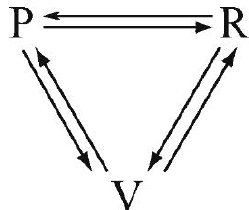
Figure 1: The Original Drama Triangle However, over time with popular usage and with the ease of drawing it on a blackboard, others began drawing it with three straight lines only - without the arrows, and pointing up like a pyramid. The triangle